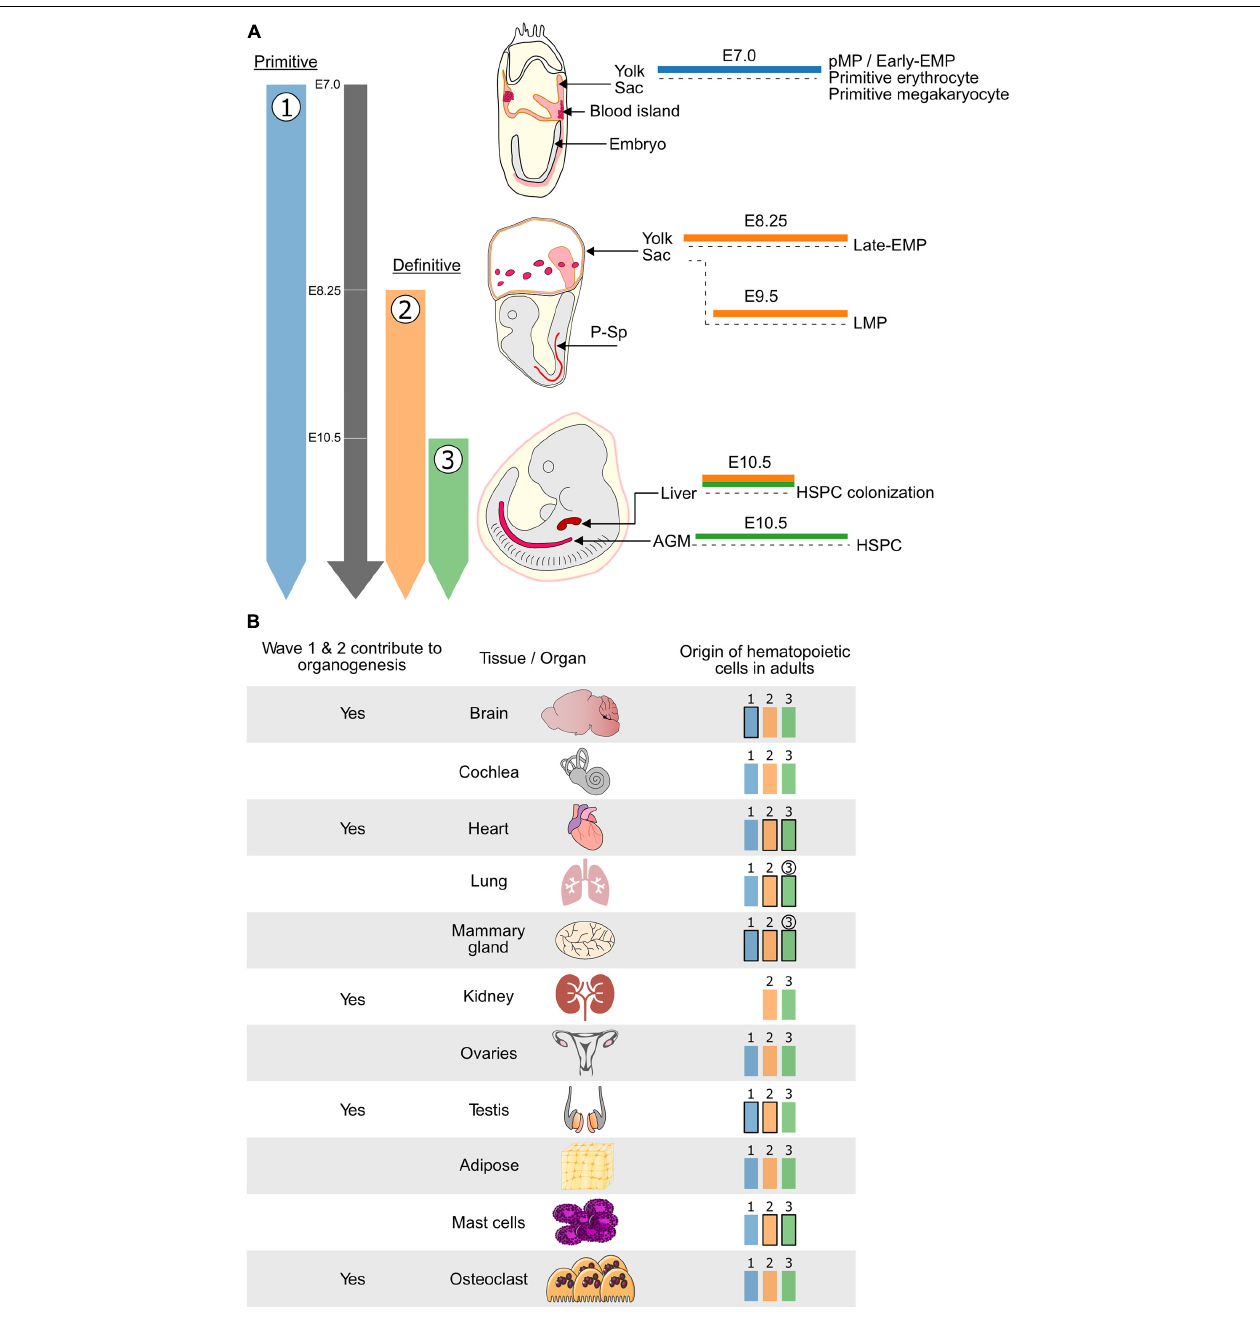
Frontiers in Cell and Developmental Biology |